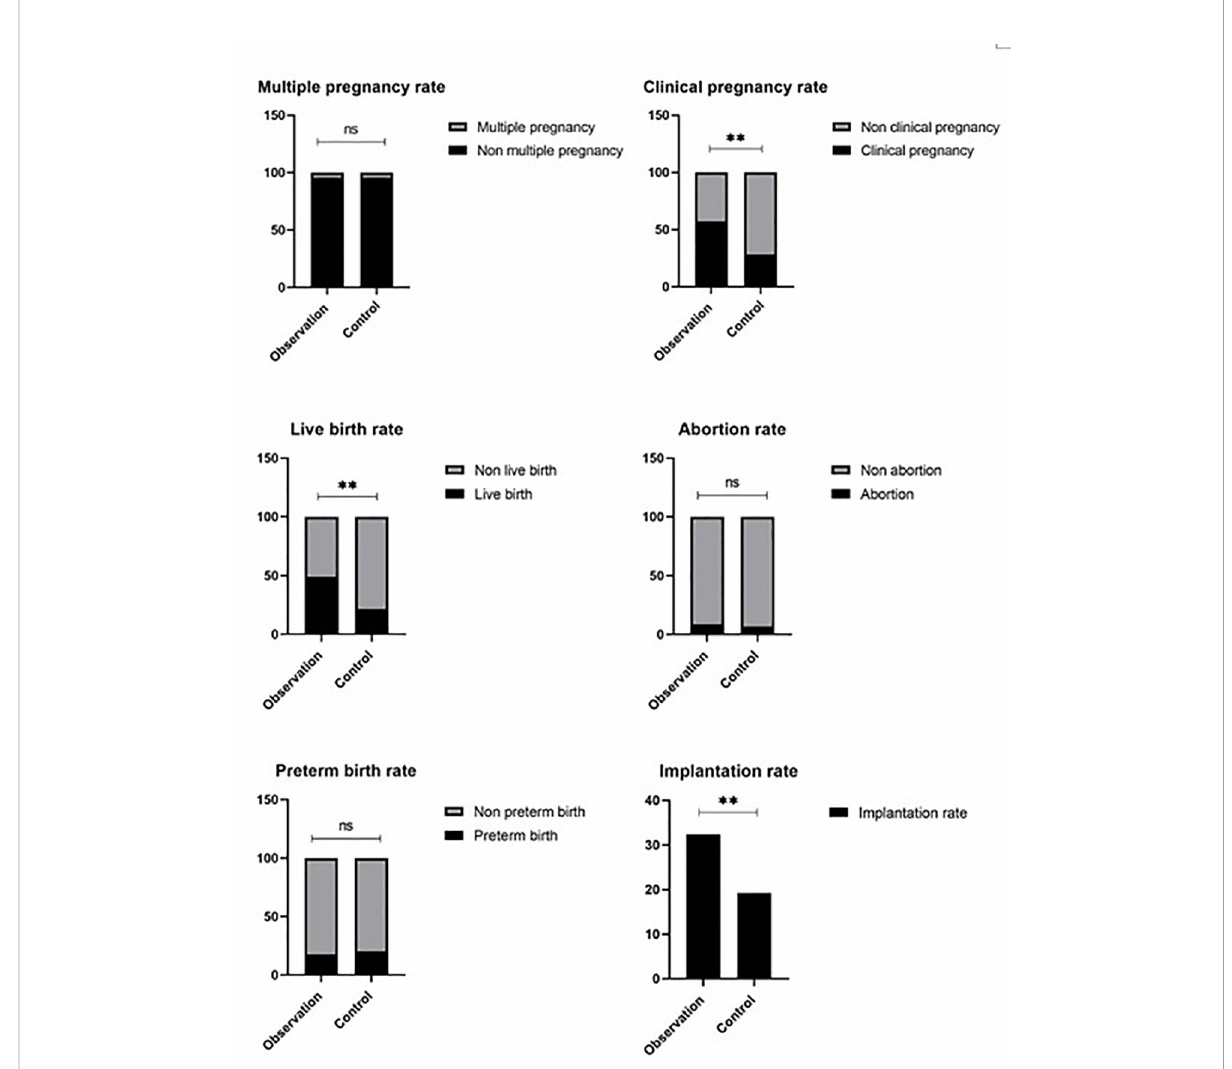
FIGURE 1 Observation group got signi fi ocantly better clinical pregnancy rate (57.4%vs28.3%, RR = 2.033, 95% CI: 1.206 – 3.426) and live birth rate 48.9% vs21.7%, RR = 2.251, 95% CI: 1.209 – 4.190) than control group ( P < 0.05). There are no signi fi cant differences in the ectopic pregnancy rate of both groups was 0), multiple pregnancy rate, and abortion rate between the two groups ( P > 0.05). ns P > 0.05, ** P <